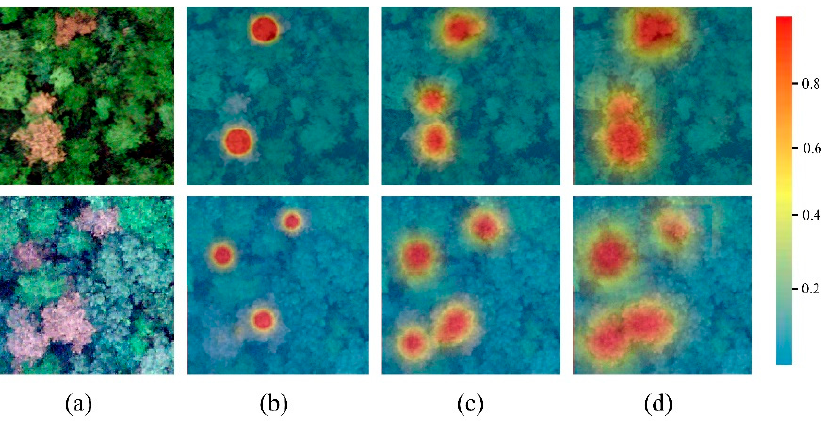
Figure 5. Training loss of the MSSCN at different Gaussian kernel parameters.